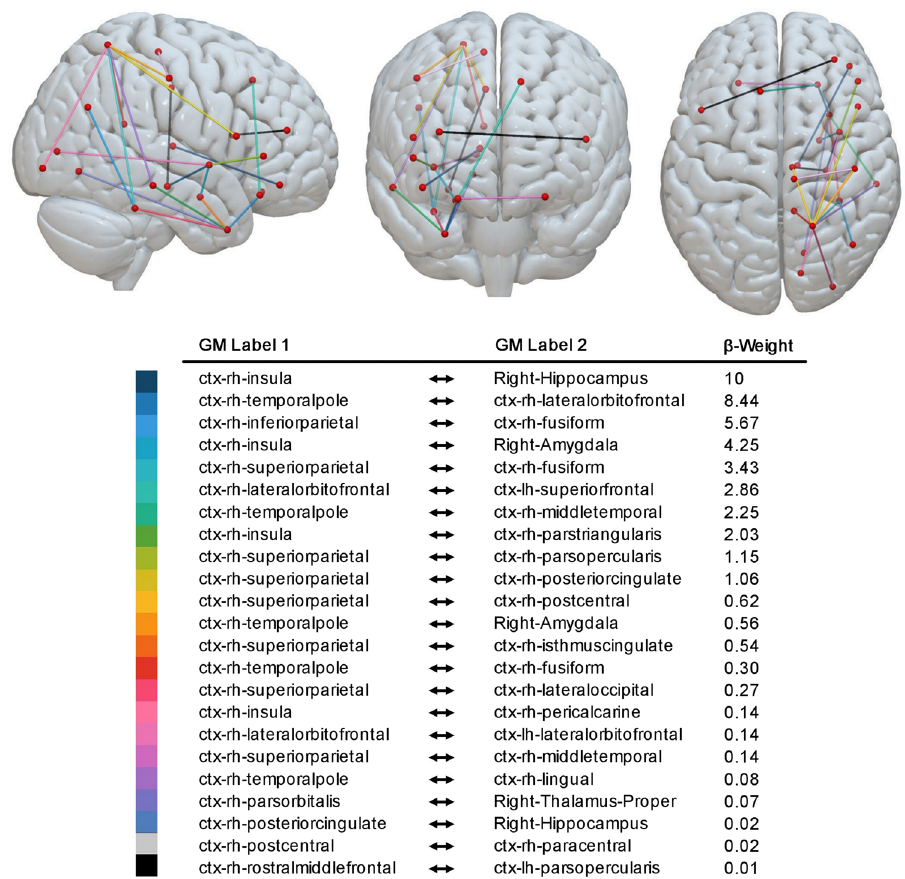
Figure 1. Results of the SVR-CLSM analysis. Support vector regression based connectome lesion-symptom mapping results using data of 203 patients. Link-based probability-map of SVR-CLSM on CoC scores after 10.000 permutations, shown at p < 0.05 (Bonferroni corrected for multiple comparisons) illustrating anatomical regions disconnected to other brain regions which are related to the core deficit of spatial neglect. Each color is associated to one disconnected link. The (dis)connectome is shown from sagittal view (right hemisphere), frontal view and superior view. The table further provides a β -weight per link. Parcellation into grey matter connectome nodes was done with respect to the Desikan–Killiany atlas 45